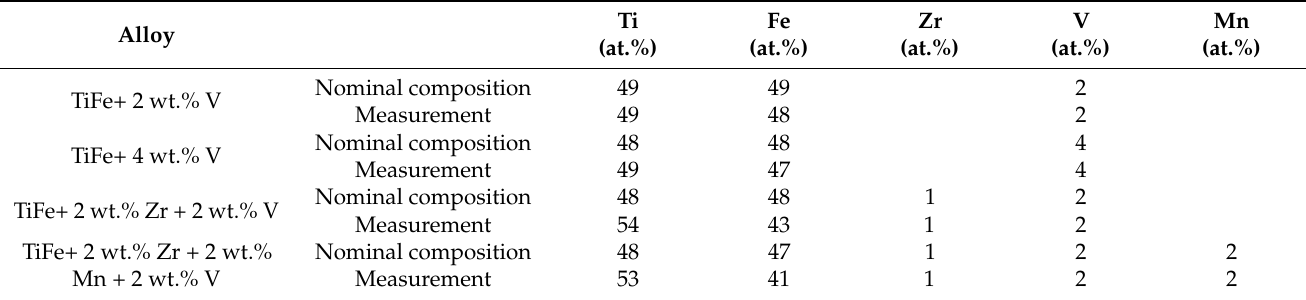
Table 1. Measured bulk composition analysis by XRF (X-ray fluorescence) spectrometer of all alloys with nominal values. Uncertainty on all values is ± 1